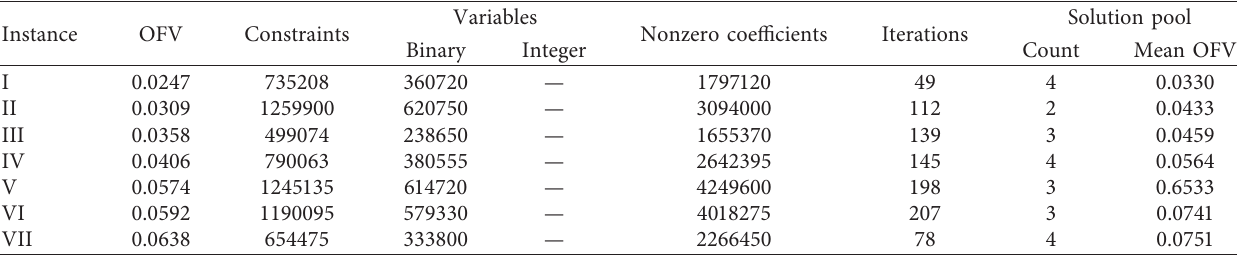
Table 7: The solving statistical information with BYCA-TSCS for the second stage by